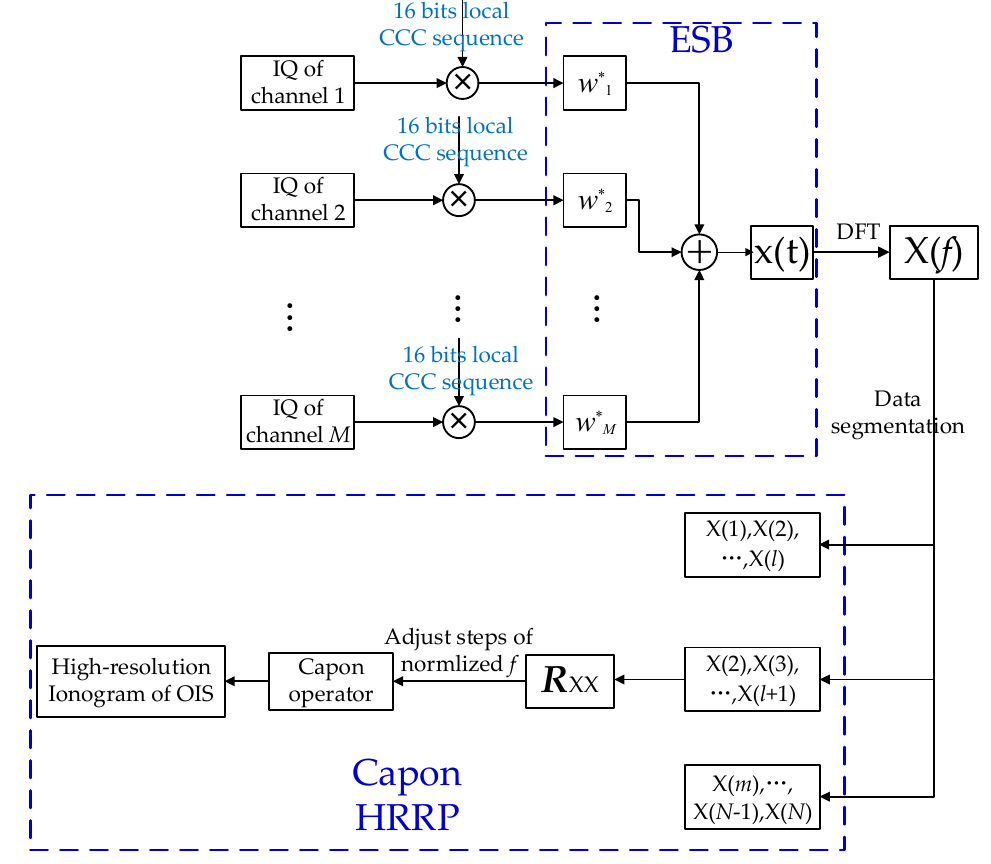
Figure 5. Data processing scheme and flow.